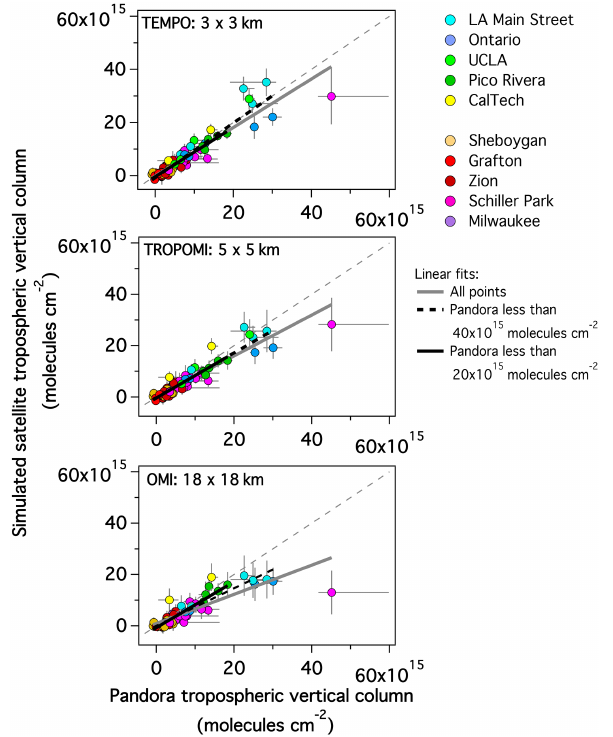
Figure 9. Scatter plot of GeoTASO TropVCs scaled to the nadir areal resolution of TEMPO (a) , TROPOMI (b) , and OMI (c) TropVCs vs. Pandora TropVCs colored by site and their associ- ated linear fits (statistics listed in Table 3). Vertical bars show stan- dard deviation of GeoTASO TropVCs within the upscaled pixel. Horizontal bars show the minimum and maximum of Pandora data within the ± 5min coincidence window. The gray dashed line indi- cates the 1 : 1